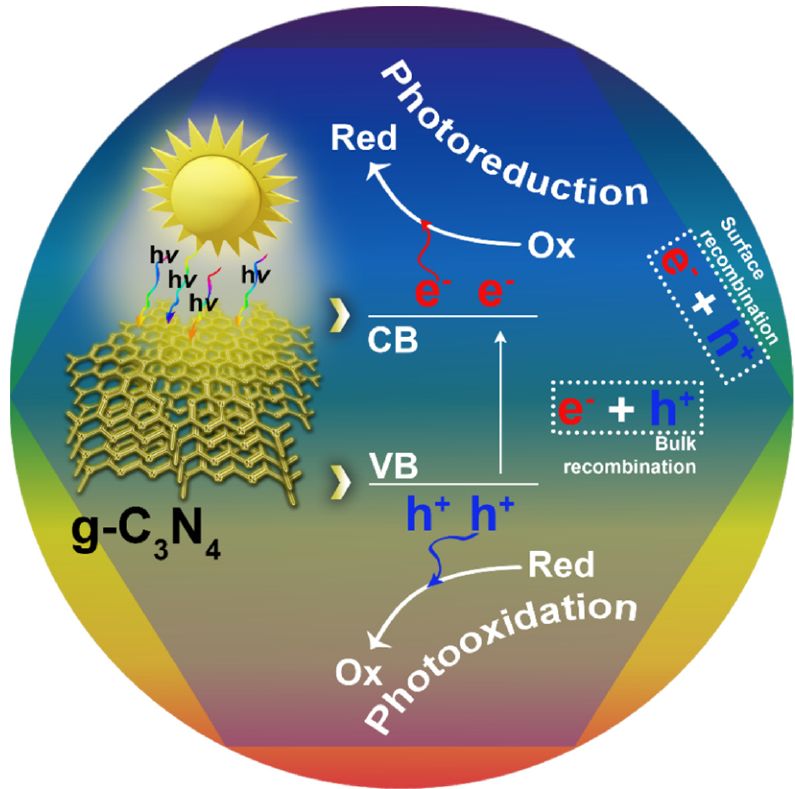
Figure 6. Schematic illustration of the photoexcitation process in g-C 3 N 4 and the formation of electron–hole pairs involving redox reactions and/or bulk/surface recombination processes.